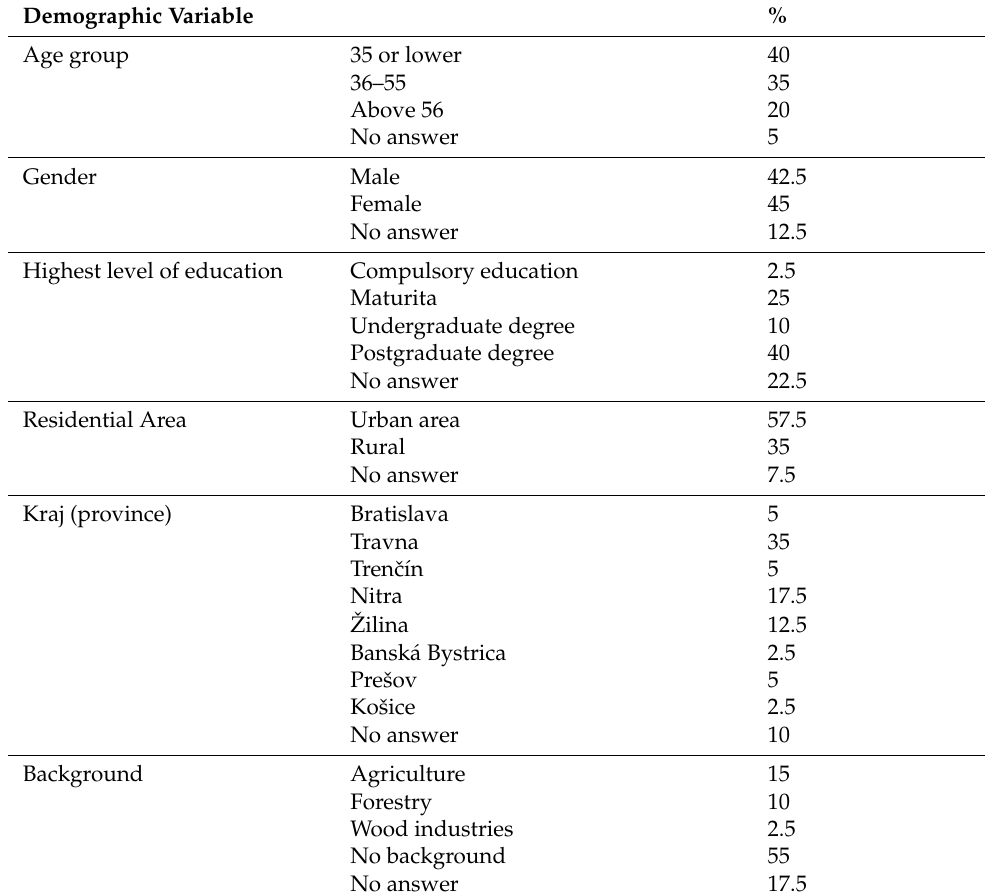
Table 1. Description of the sample (N =